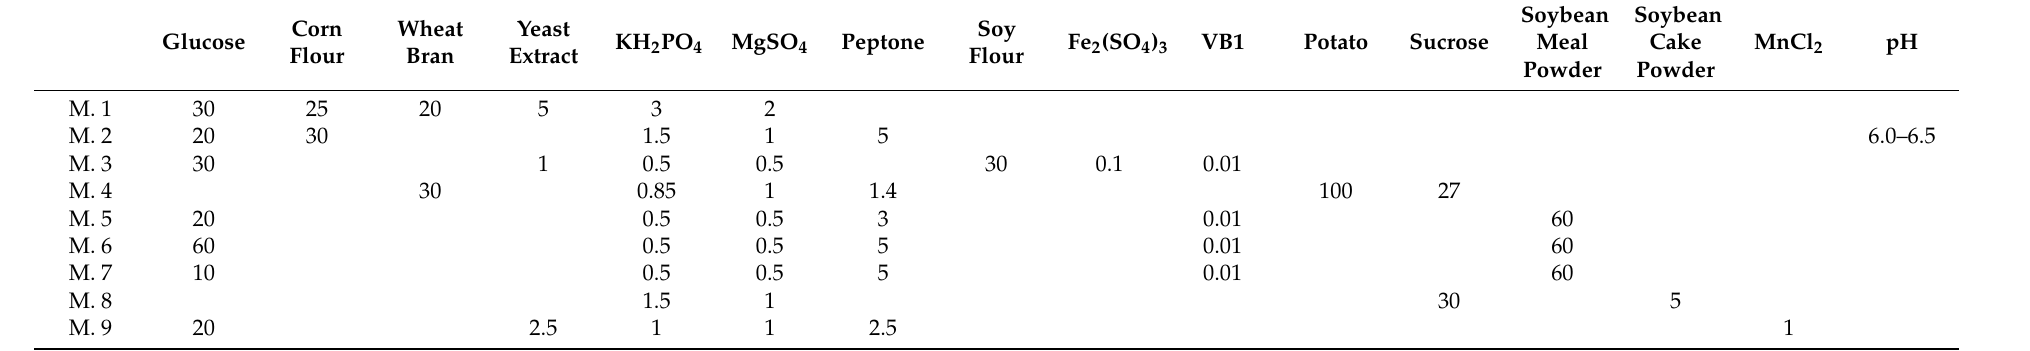
Table 1. Components of nine